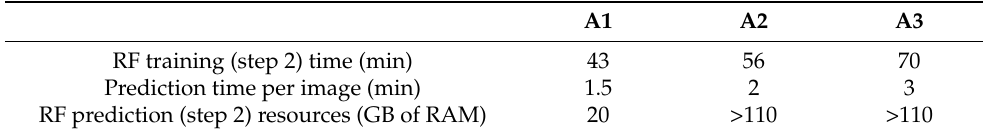
Table 7. Computational and time resources required by the